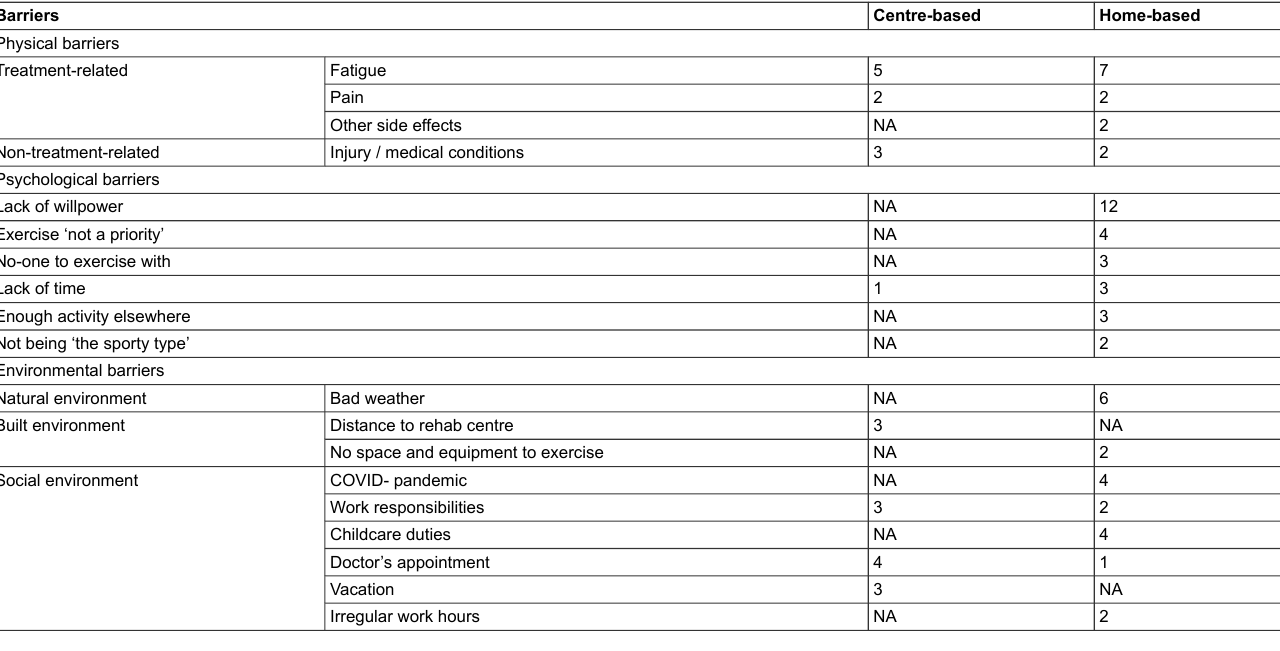
Table 3: Barriers toward exercise participation. Barriers Physical